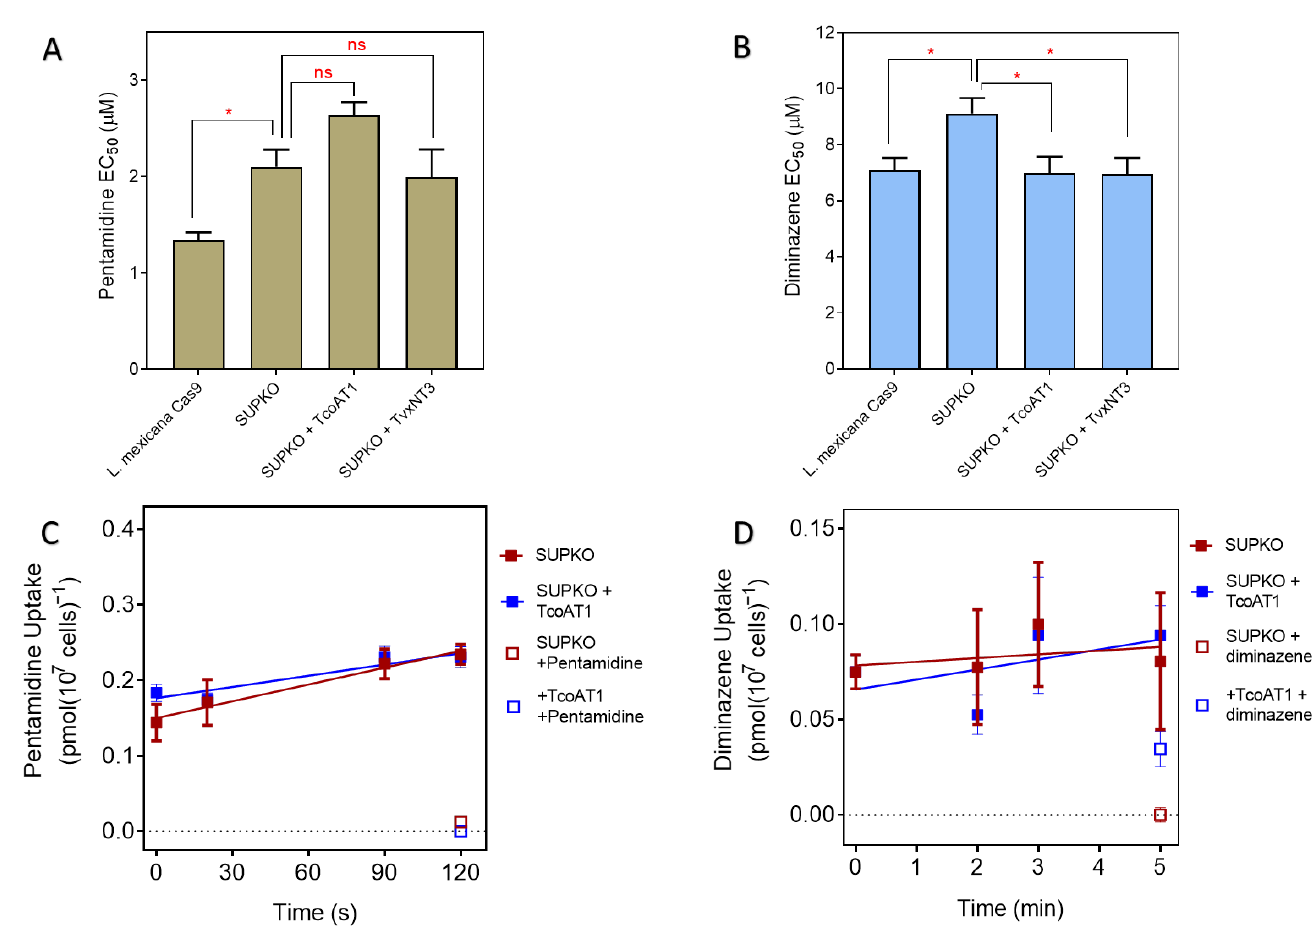
Figure 7. Effect of expression of T. congolense and T. vivax nucleoside transporters on the activity and uptake of trypanocides in L. mexicana . ( A ) Pentamidine sensitivity and ( B ) Diminazene sensitivity. Sensitivity is represented as EC 50 averages of 4 independent determinations (mean ± SEM). * p < 0.05; ns = not significant by unpaired Student’s t -test. Uptake of ( C ) 25 nM [ 3 H]-Pentamidine or ( D ) 50 nM [ 3 H]- in SUPKO+TcoAT1 and SUPKO control cells. At each predetermined time point, uptake was stopped in the corresponding sample by the addition of high concentration of unlabeled substrate followed by centrifugation. Graph was plotted using the average uptake (mean ± SEM) in pmol(10 7 cells) − 1 ) of an experiment performed in triplicate. Lines were calculated by linear regres- sion.